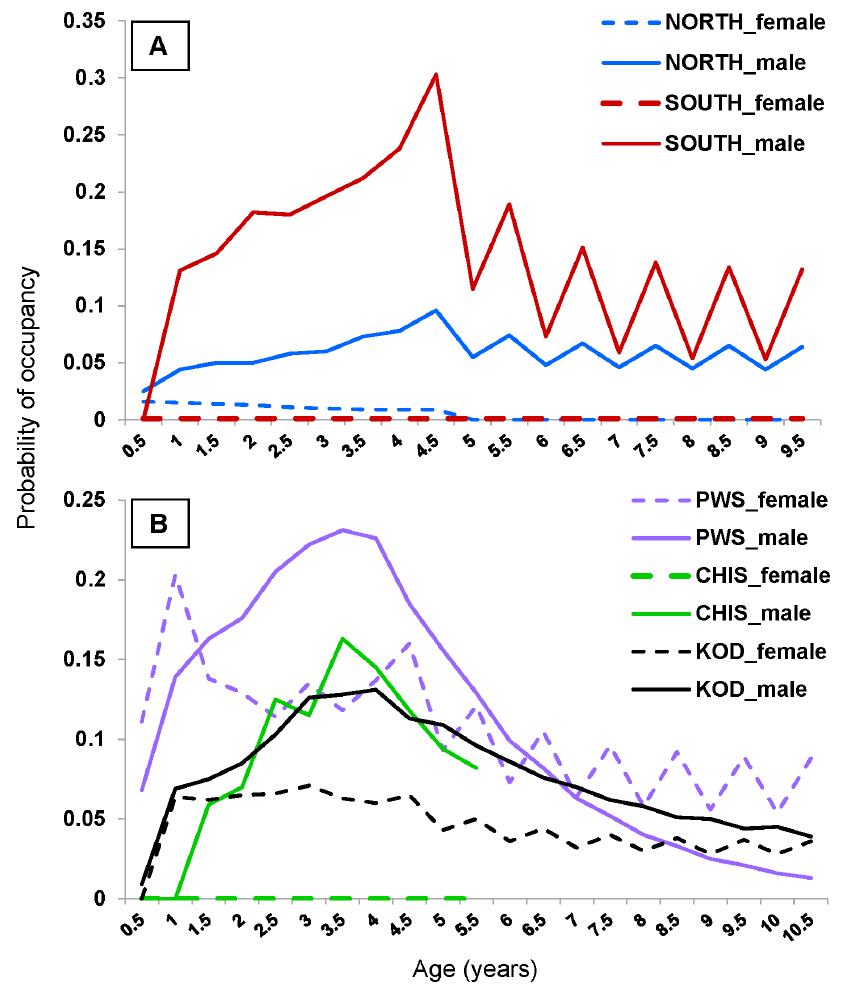
Figure 2. Occupancy probabilities of Steller sea lions being in non-natal DPS during breeding and non-breeding seasons. Estimated seasonal age- and sex-specific occupancy probabilities for sea lions being in their non-natal Distinct Population Segment (DPS) during breeding (whole number) and non-breeding ( + 0.5) seasons. Dashed lines represent females and solid lines represent males. Graph A shows estimated probabilities of occupancy in the opposite DPS for EDPS sea lions from the northern (NORTH) and southern (SOUTH) sub-DPS within Southeast Alaska. Graph B shows estimated probabilities of occupancy in the opposite DPS for WDPS sea lions from sub-regions Kodiak Island (KOD), Chiswell Island (CHIS), and Prince William Sound (PWS) within the central Gulf of Alaska; see Figure 1.